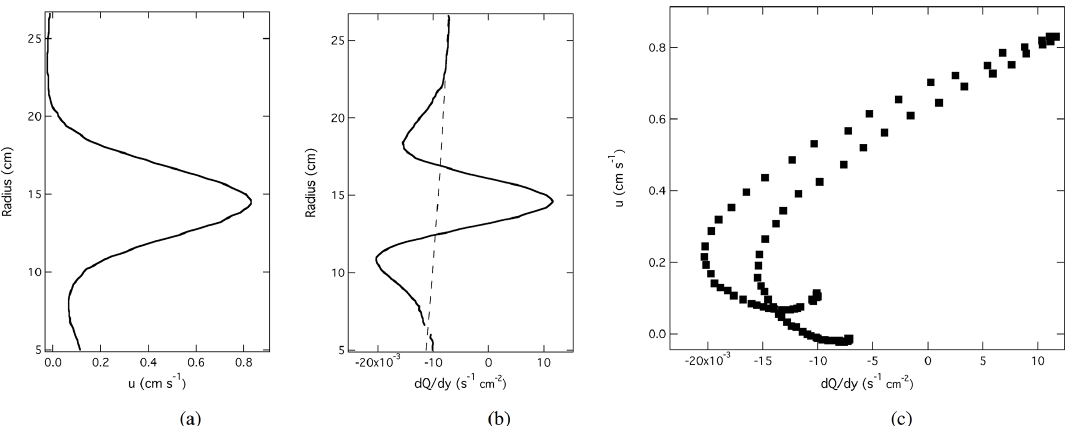
Figure 3. A typical azimuthal and time mean jet flow, driven by a differentially rotating ring as used by Aguiar et al. (2010), derived from particle image velocimetry measurements. Panel (a) shows the radial profile of azimuthal velocity ( u ), while panel (b) shows the corresponding radial gradient of shallow-water potential vorticity, clearly confirming a change of sign of ∂Q/∂y = − ∂Q/∂r at r (cid:39) 12 and 17cm, on either side of the barotropic jet ( ∂Q/∂y due solely to the gradient of 2 (cid:127)/h shown as a dashed line). Panel (c) shows a scatter plot of u against ∂Q/∂y , illustrating the nearly linear relationship between the two quantities within the barotropically unstable jet for u > 0 . 2cms − 1